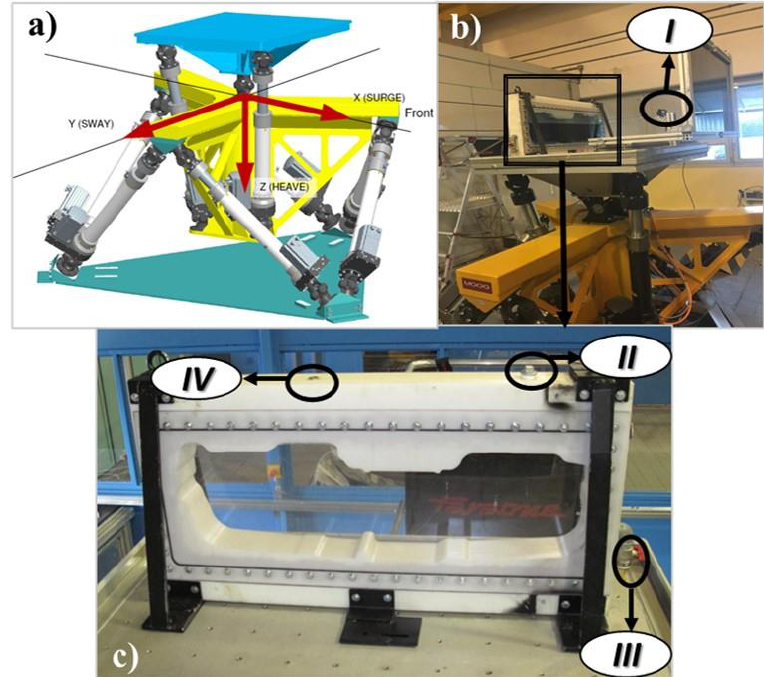
Figure 1. The Fuel Tank Test System and employed Cartesian coordinate system: ( a ) Drawing of the Moog test rig; ( b ) Real Moog test rig installed in FCA | Fiat Chrysler Automobiles; ( c ) Tank under